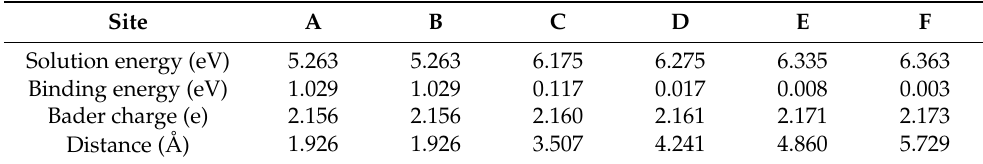
Figure 3. The solution energies of He occupied different TIS in the W-Y system, where the inset 3D model represents the initial positions of the He atoms. Table 2. The solution energy, binding energy, Bader charge, and distance from He to Y in the equilibrium W-Y